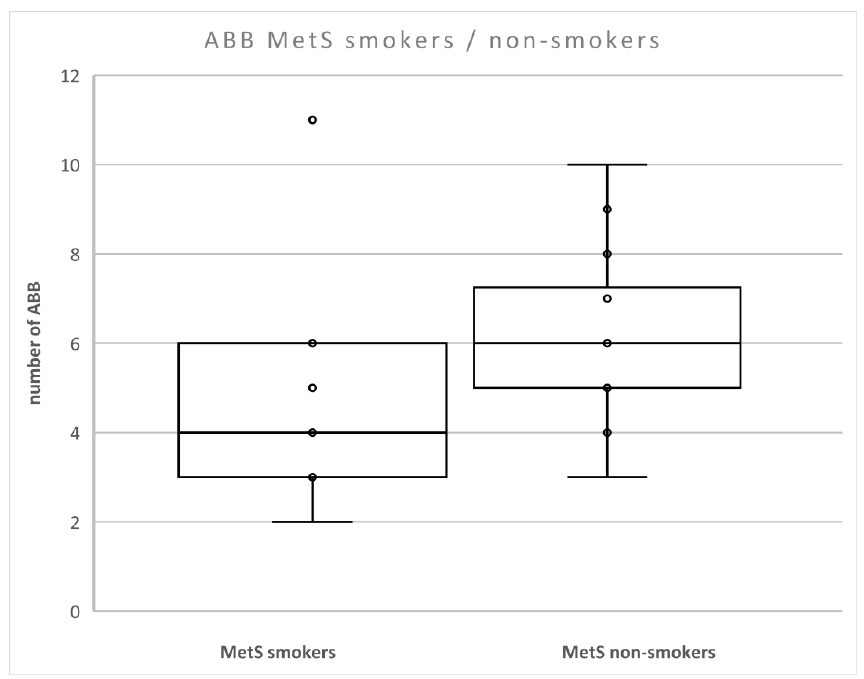
Figure 3. Number of aberrations in smokers and non-smokers with MetS. Legend: The horizontal line in the boxes indicates the position of the median, the ends of the boxes define the 25th and 75th percentiles, and error bars mark the 10th and 90th percentiles. Y is an outlier.